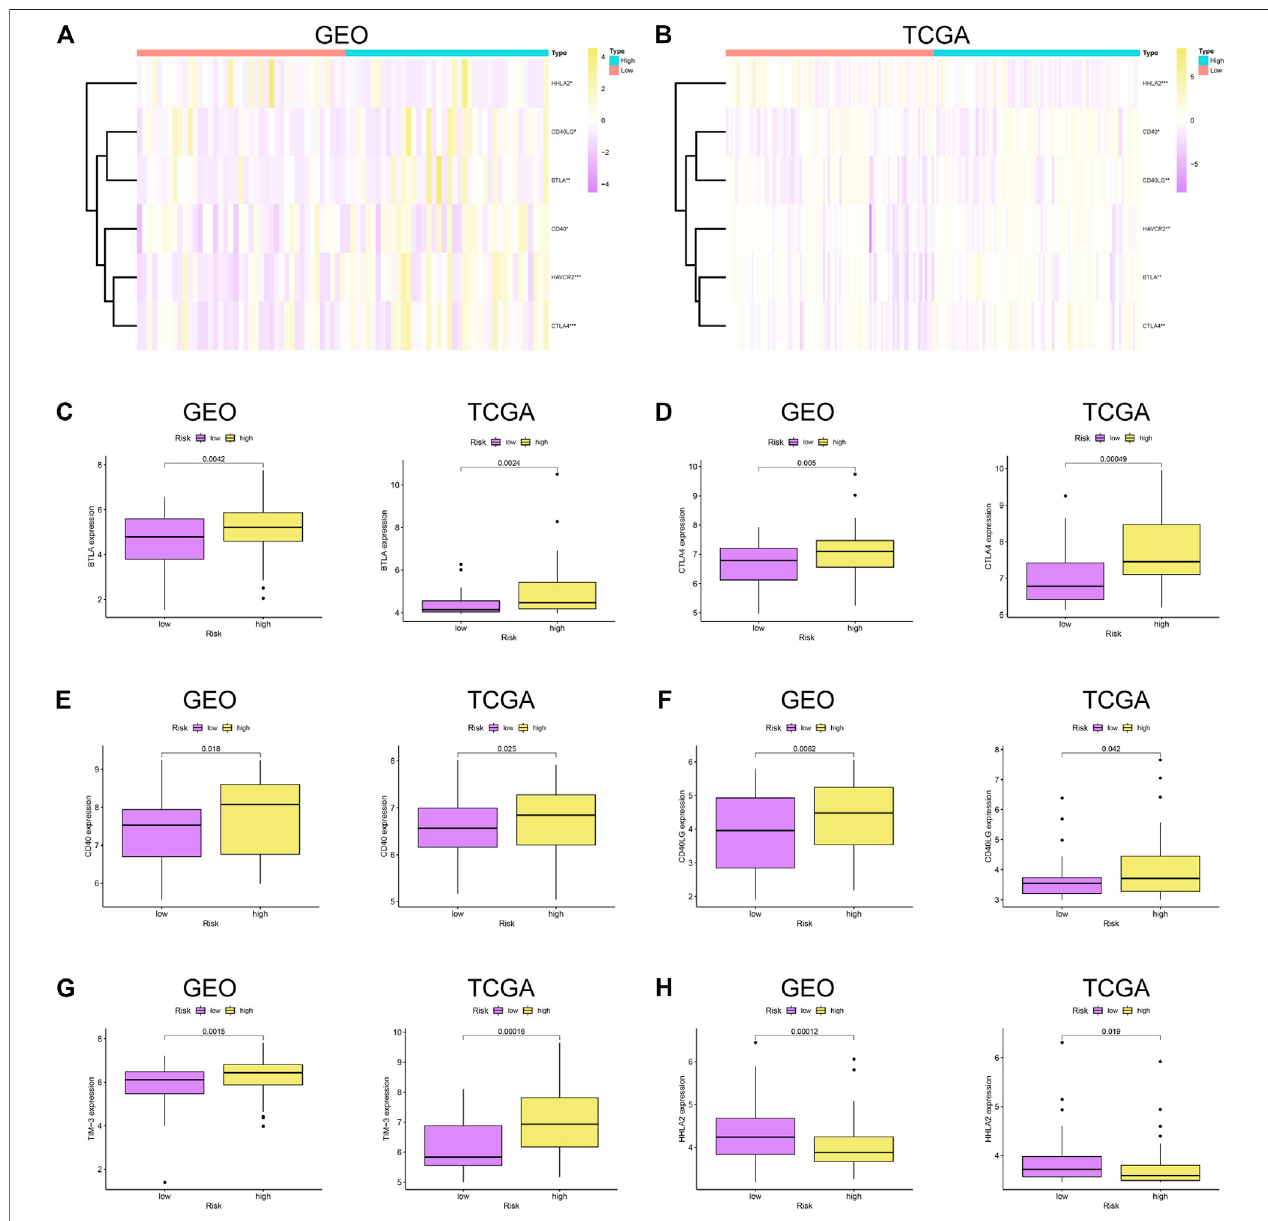
FIGURE 6 | Immune checkpoint analysis. (A – B) Heatmap of immune checkpoints between high- and low-risk patients in GSE53625 and TCGA datasets. Differential expression of immune checkpoints in high- vs. low-risk patients: (C) BTLA, (D) CTLA4, (E) CD40, (F) CD40LG, (G) TIM-3, and (H) HHLA2.